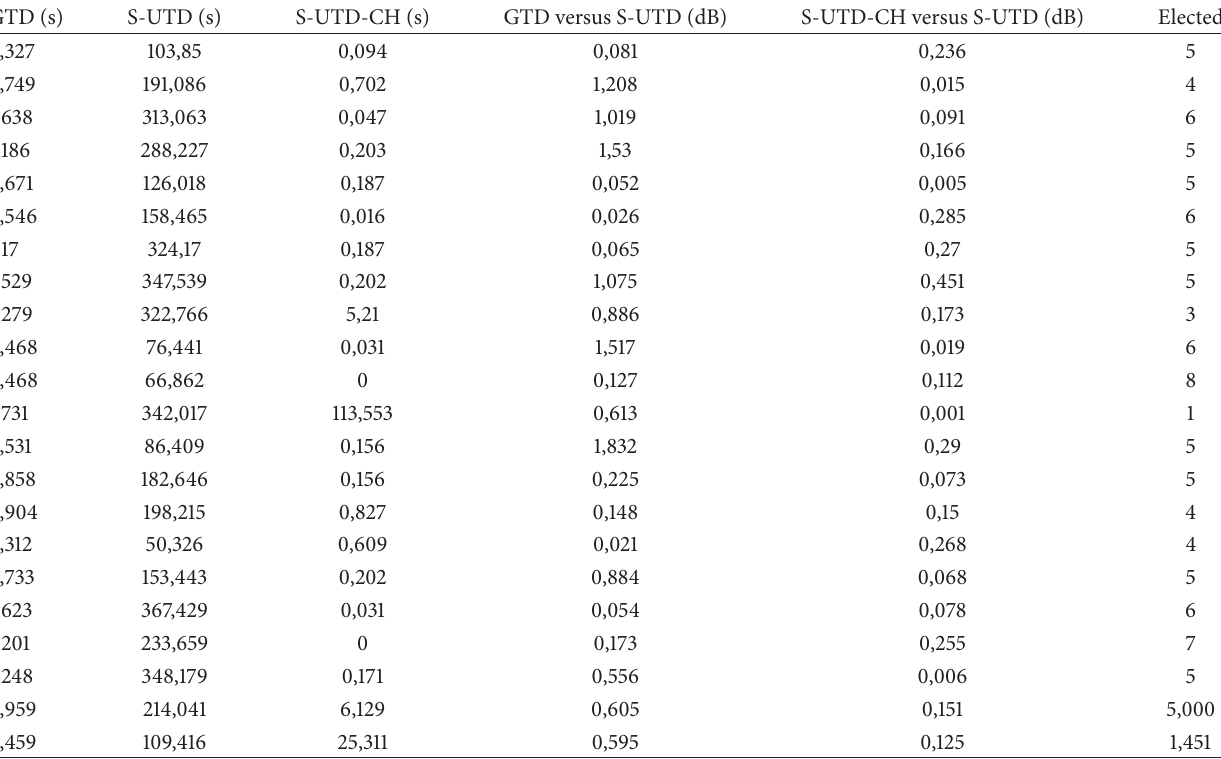
Table 4: Comparison results of highly lower receiver height